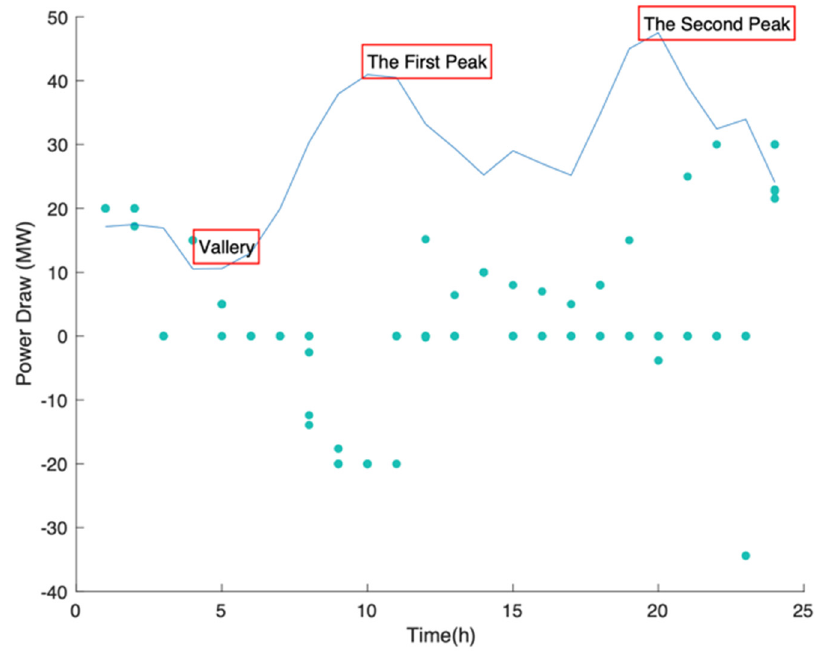
Figure 4. The preferred operating point of Audi e-tron when considering uncertainties.